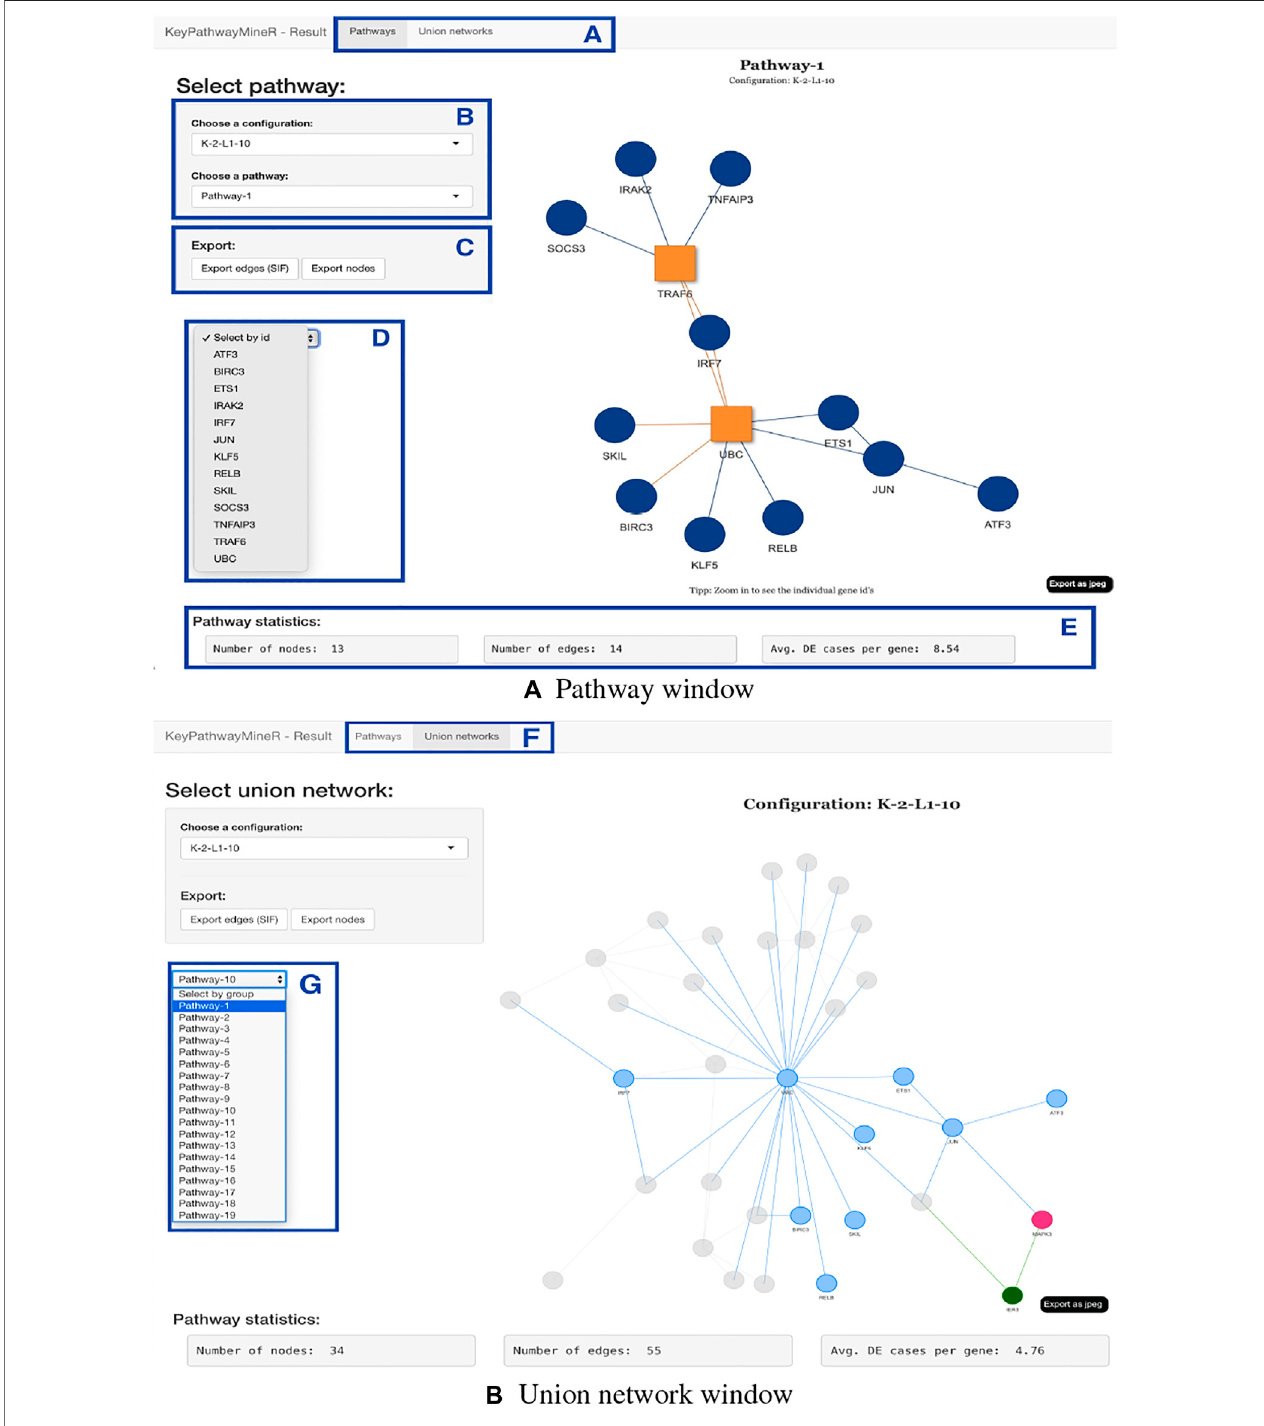
FIGURE 2 | Shiny app for visualizing, browsing, and saving pathways from a result object. The displayed subnetworks were extracted from SARS-CoV-2 gene expressiondata. (A,F) Theusercanswitchbetweenpathwayandunionnetworkview. (B) Paneltoselectwhichparametercon fi gurationandsubnetworktovisualize. (C) Export buttons that allow the extraction of the current pathway as edges or nodes. (D) The user can select a gene from the network for closer inspection. (E) For every network, statistics are displayed, which provide information on the number of nodes, edges, and the average number of active cases per node. (G) In the union networkview,theselectionpanelallowsselectingpathways toexaminefromwhichsubnetwork thenodes originate.WhenusingINEStorunKPM,theexceptionnodes are marked as red squares, as shown in the pathway view.